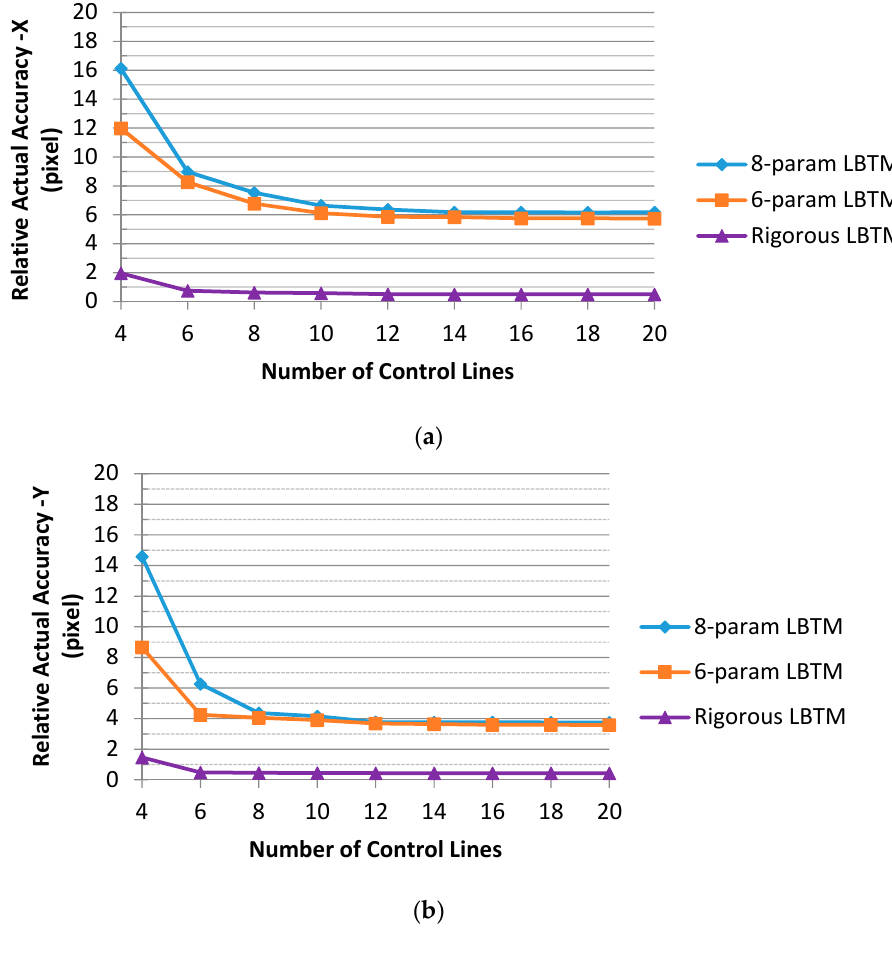
Figure 6. Relative actual accuracy variations of image rectification by different LBTMs with the increase of control lines: ( a ) accuracy variations in the X direction and ( b ) accuracy variations in the Y direction.